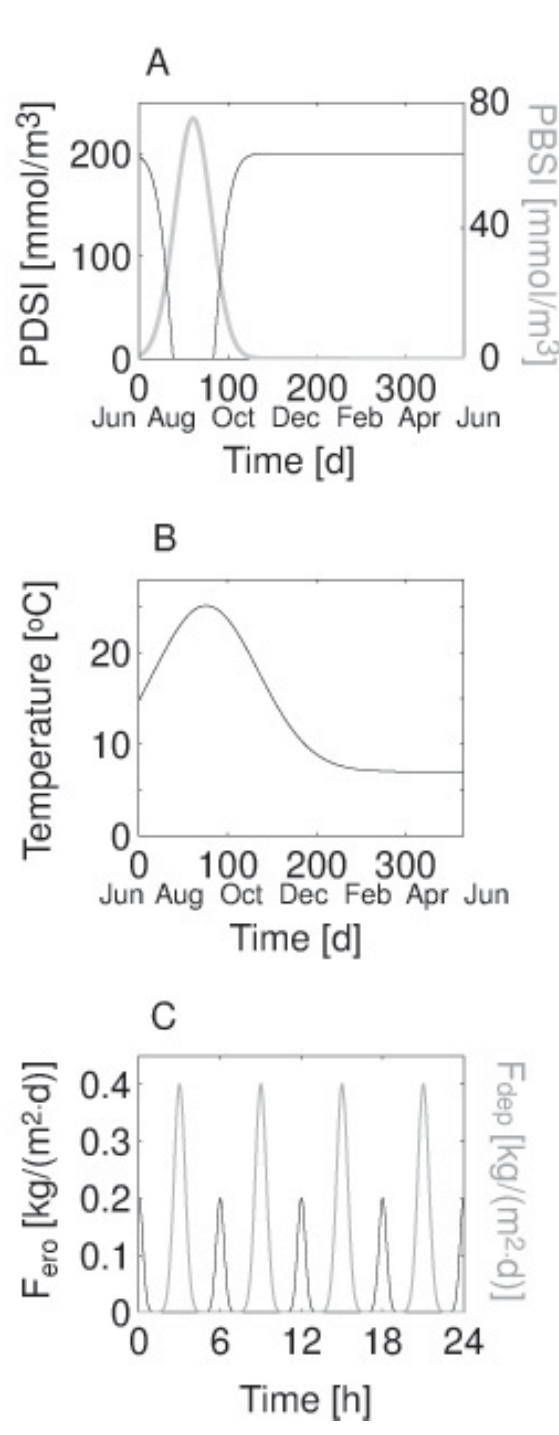
Fig. 2. Idealized boundary conditions used in the sensitivity analy- sis of the benthic model. (A) Biogenic silica (PBSI) and dissolved silica (PDSI) concentrations in the water column, (B) temperature and (C) erosion ( F ero ) and deposition ( F dep ) flux of suspended mat-